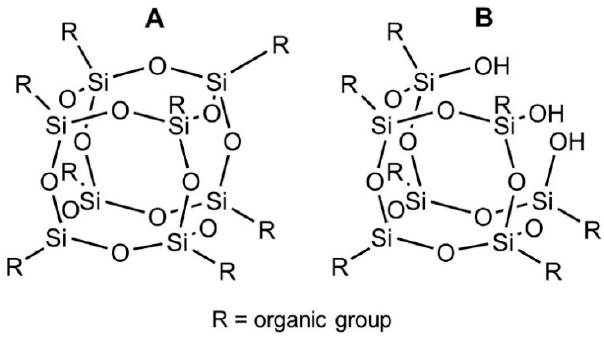
Figure 1. Completely ( A ) and partially condensed ( B ) polyhedral oligomeric silsesquioxanes